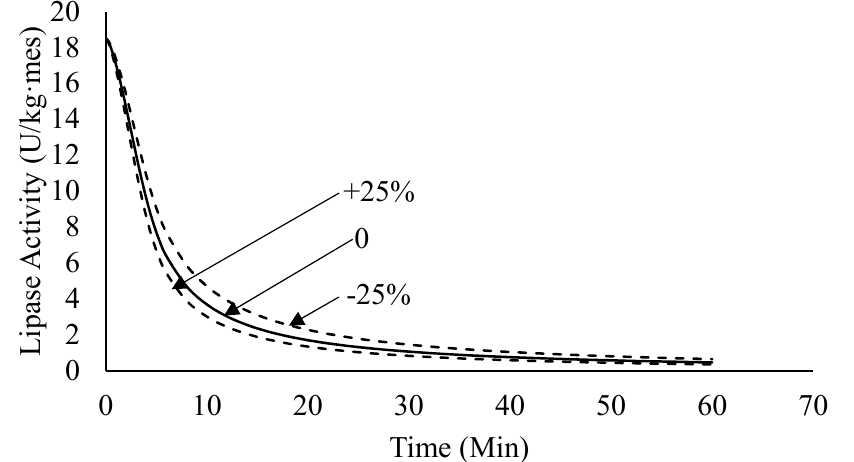
Figure 11. Sensitivity analysis of the developed model to changes in value of k 0dec with respect to predicted in vivo residual lipase activity inside OPF after immersion in hot water at 343 K for 60 min.